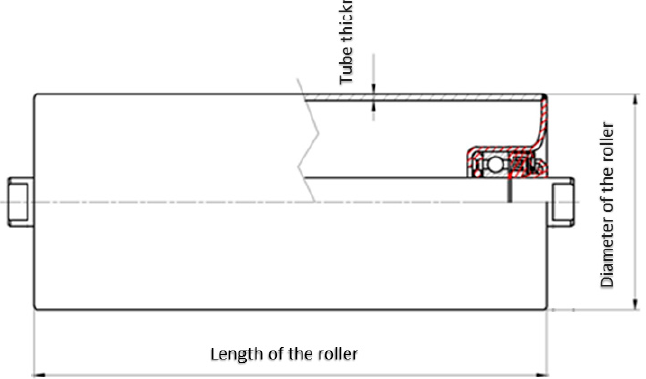
Figure 5. Geometry of the rollers.